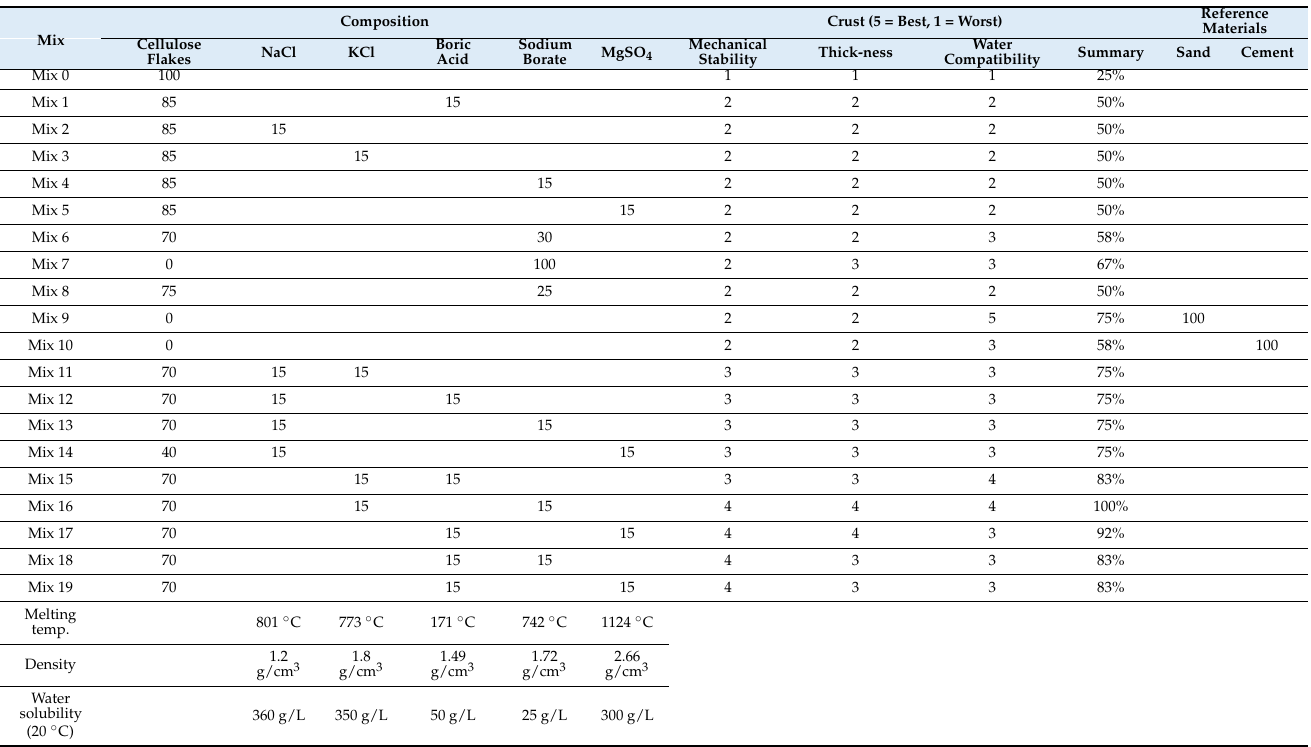
Figure 5. Optimized composition for a stable crust; 15% boric acid, 15% KCl and 70% cellulose flakes. Table 3. Summary of the recipe development. See text for